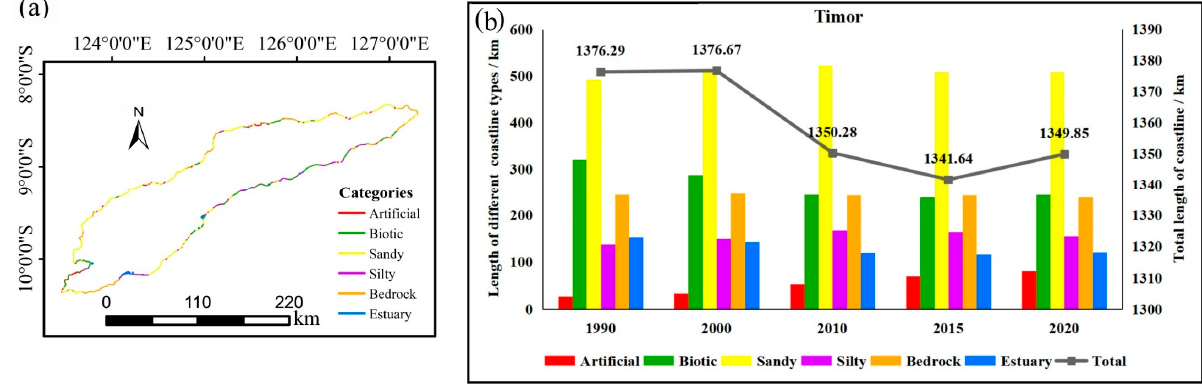
Figure 8. The coastline in Sri Lanka. ( a ) Spatial distributions of coastline in 2020 and ( b ) length sta- tistics of different coastline types from 1990 to 2020.